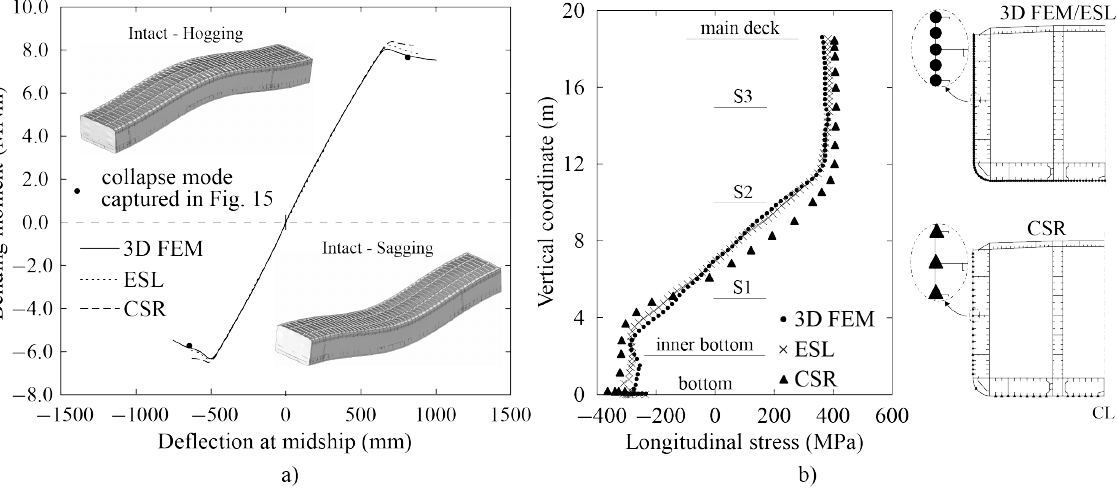
Figure 12. Response of intact ship under vertical bending moment. ( a ) Bending moment–deflection curves. ( b ) Longitudinal stress distribution to vertical coordinate at the midship under hogging